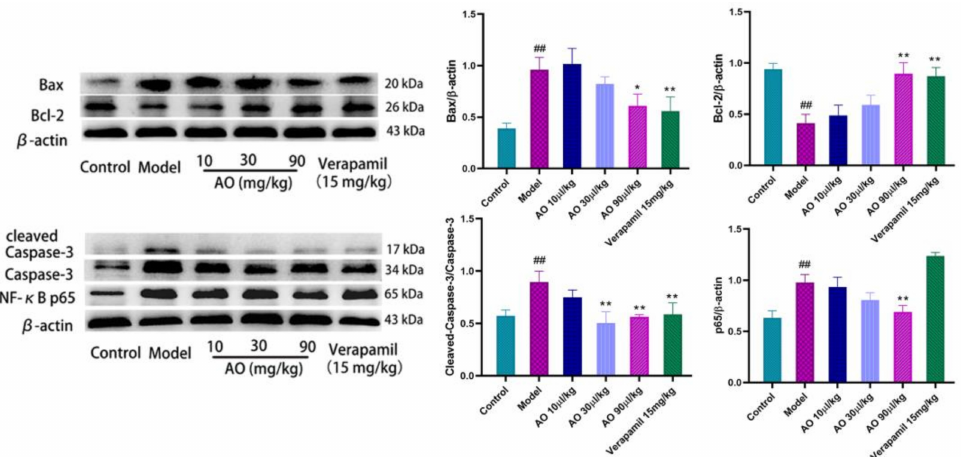
Figure 7. Effect of AO on the expression of proteins related to apoptosis and inflammation in kidneys of AKI rats induced by GM. ## p < 0.01 vs. control group. * p < 0.05 ,** p < 0.01 vs. model